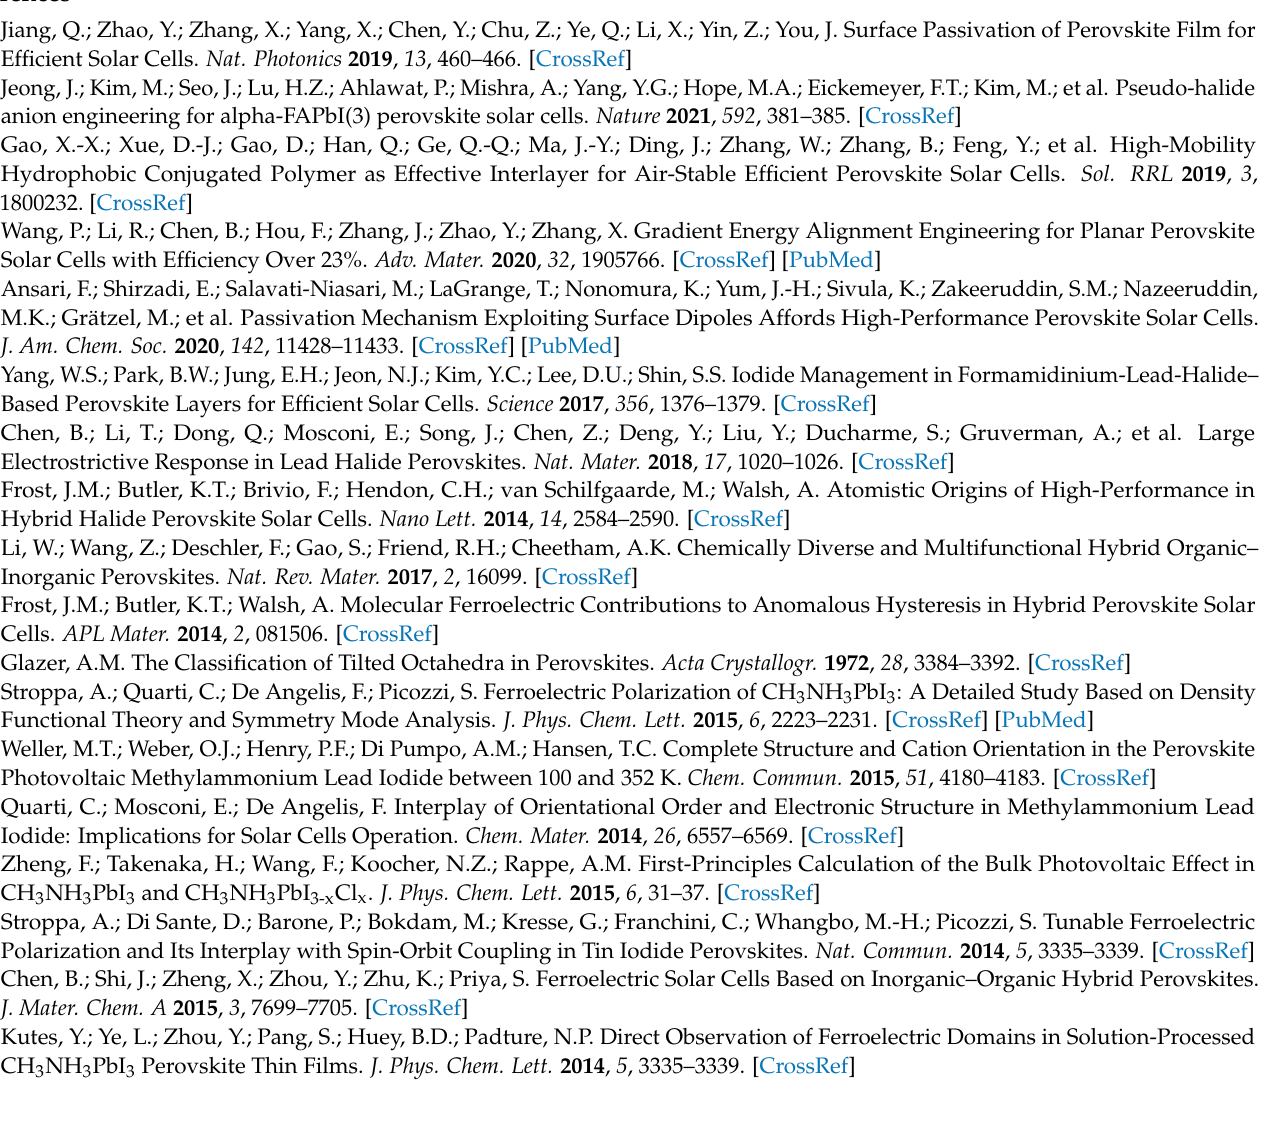
− 30 ◦ C–110 ◦ C, Figure S5: Impedance and phase shift fitting results obtained by using the proposed equivalent circuit, Figure S6: Temperature dependencies of the passive elements considered in the proposed equivalent circuit during heating and